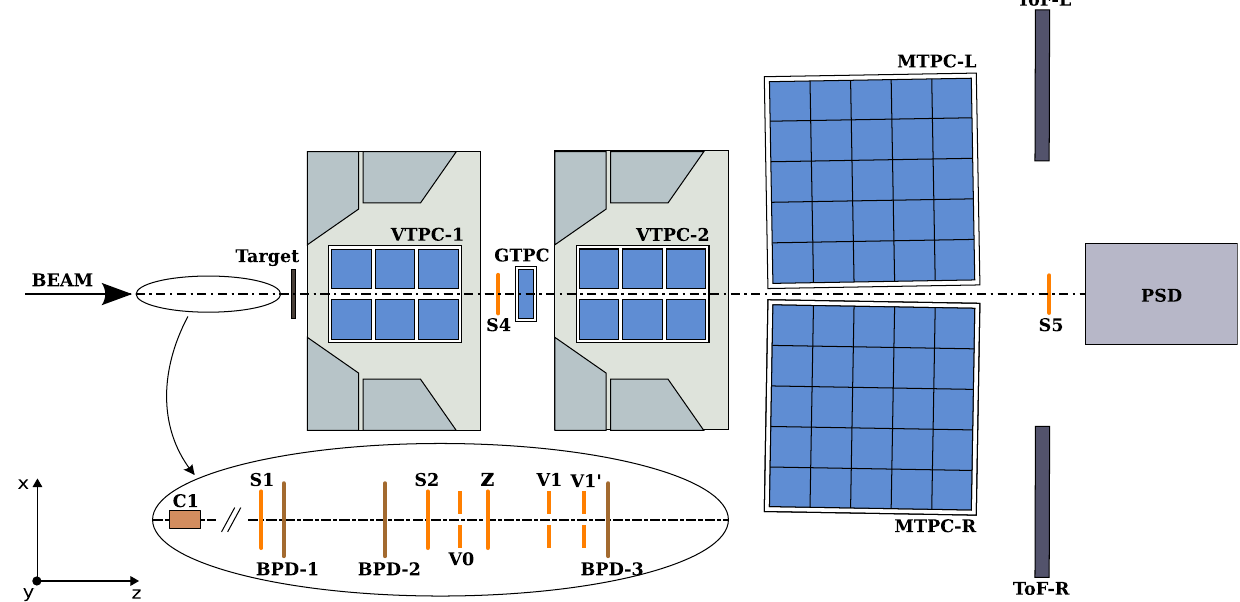
Fig. 1 The schematic layout of the NA61/SHINE experiment at the CERN SPS [19] showing the components used for the Be + Be energy scan(horizontalcut,nottoscale).Thebeaminstrumentationissketched in the inset (see also Fig. 2 below). Alignment of the chosen coordinate